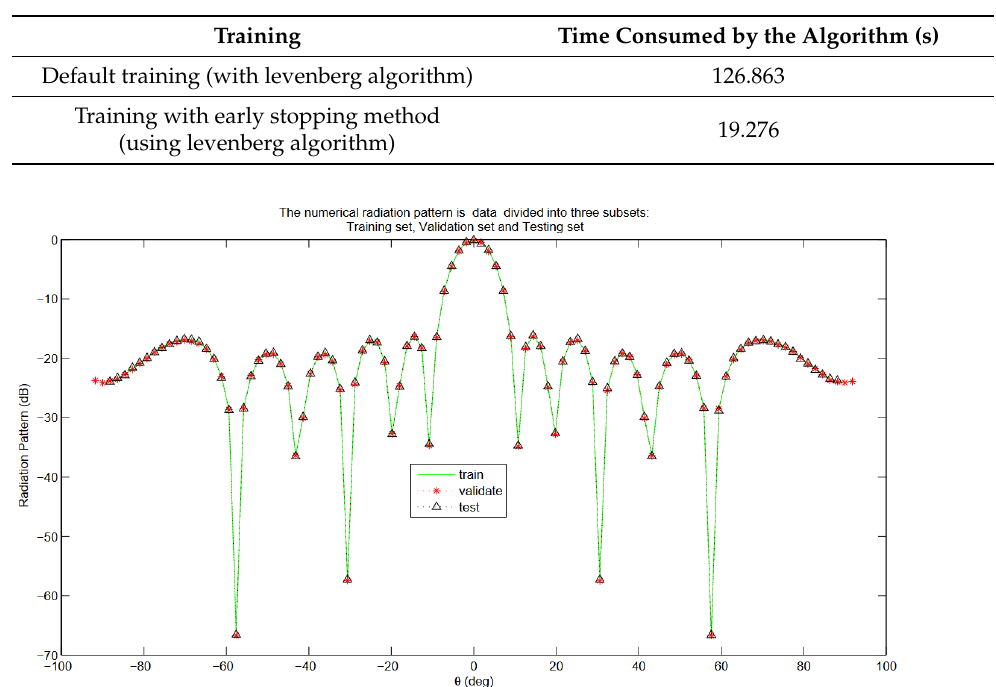
Figure 28. Radiation field data were divided into three subsets: a training set, validation set, and testing set. The parameters chosen to simulate the suggested almost periodic array antennas were: φ = 0 deg, N x = 3 elements, and d x = 2 λ = 108